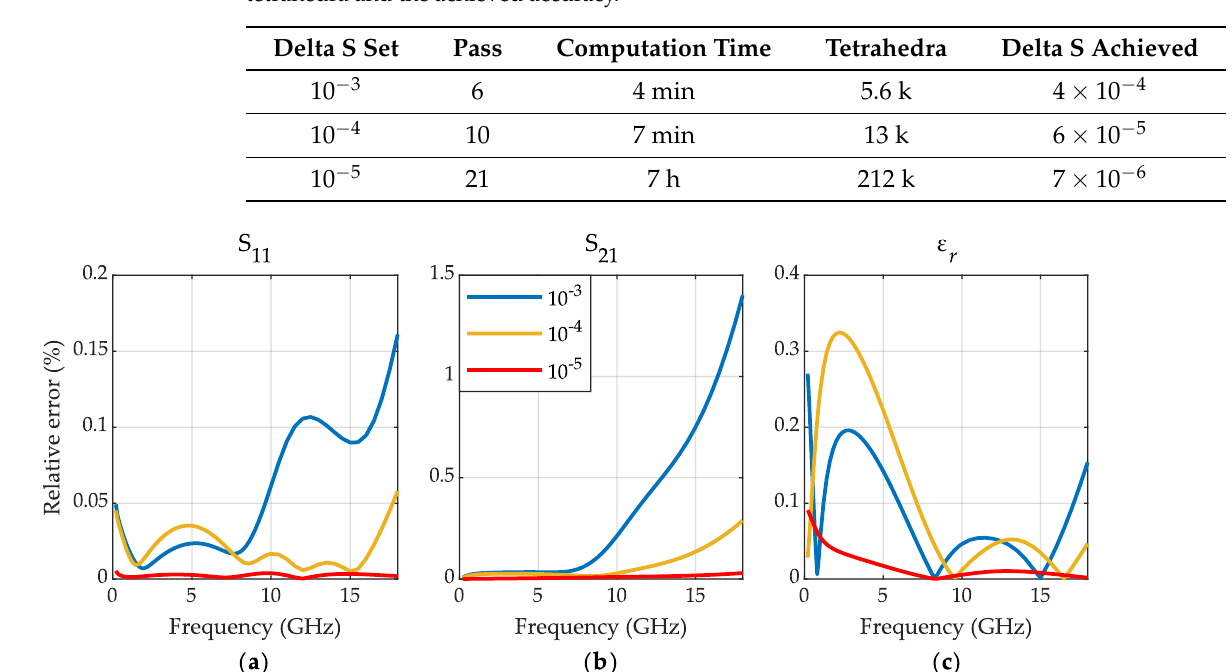
Table 1. Juxtaposition of the simulation parameters for different values of accuracy (the parameter Delta S) set—the number of passes to converge, the computation time, the number of simulated tetrahedra and the achieved accuracy.